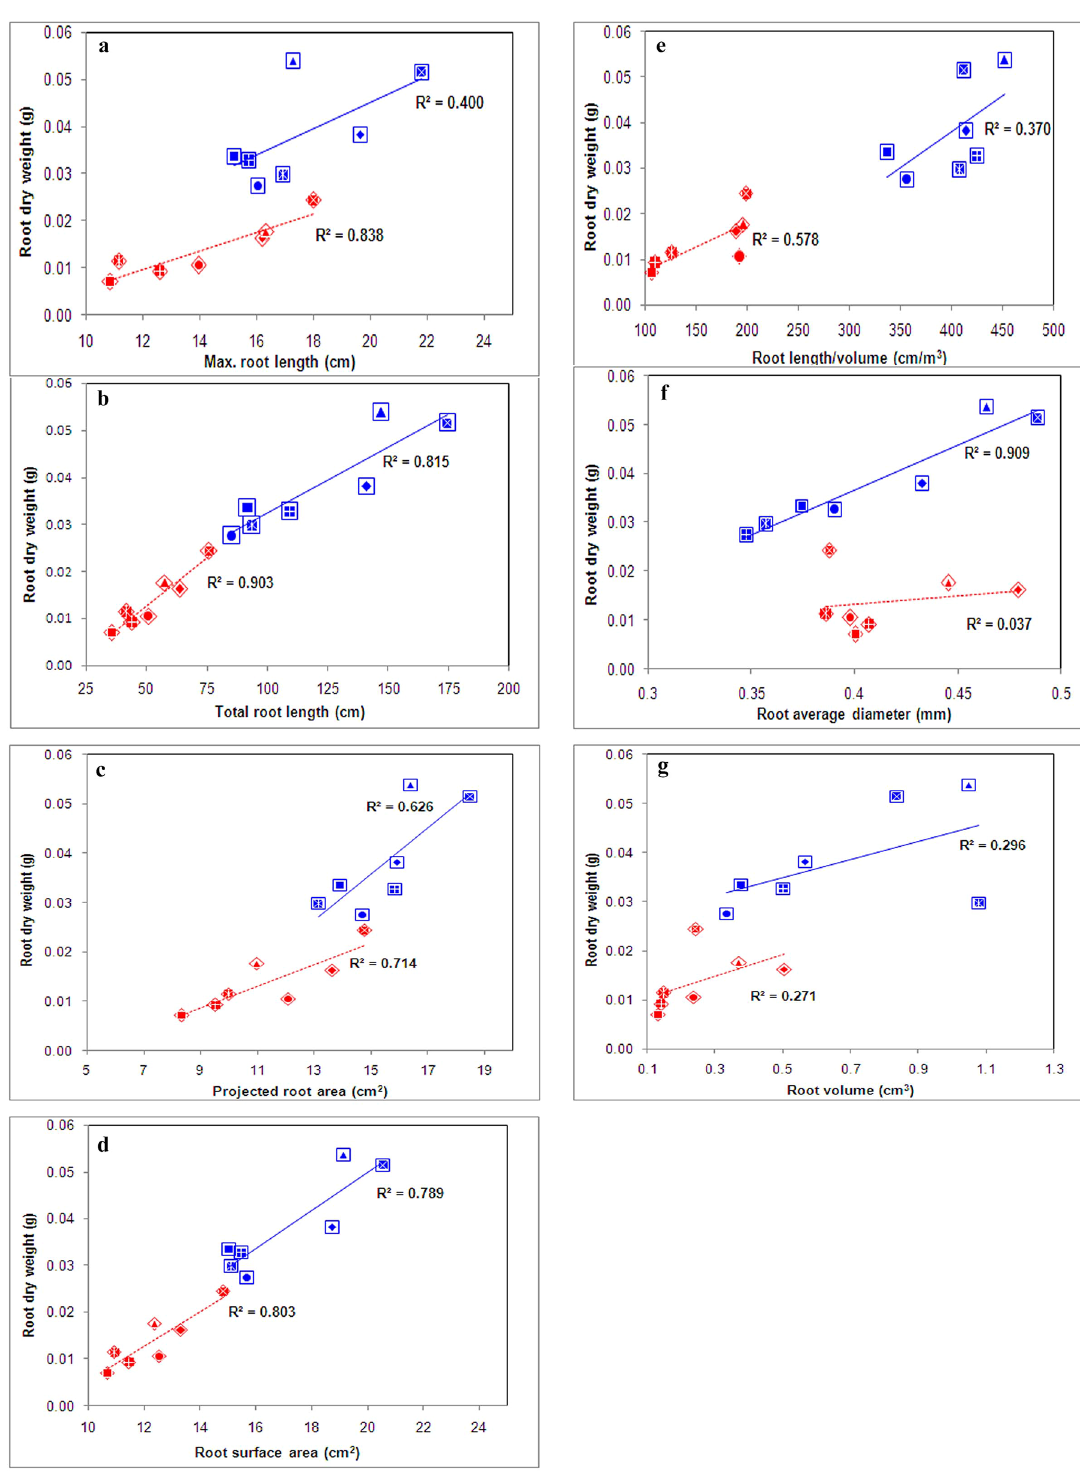
Figure 3. Phenotypic relationship between root dry weight and root parameters across different concentrations of phosphorus under hydroponics at 14 (red = ◊) and 28 (blue = □ ) days after sowing. ⊠ − 0.5 ppm, ♦ − 1